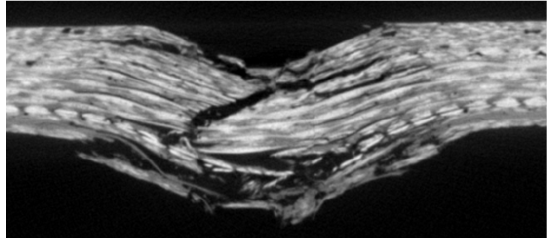
Figure 9: Tomogram of an hybrid Kevlar/fiber-glass laminate after the impact (v = 8